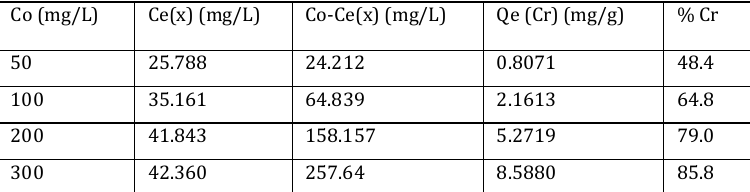
Table 8: Effect of concentration on the removal of chromium from aqueous